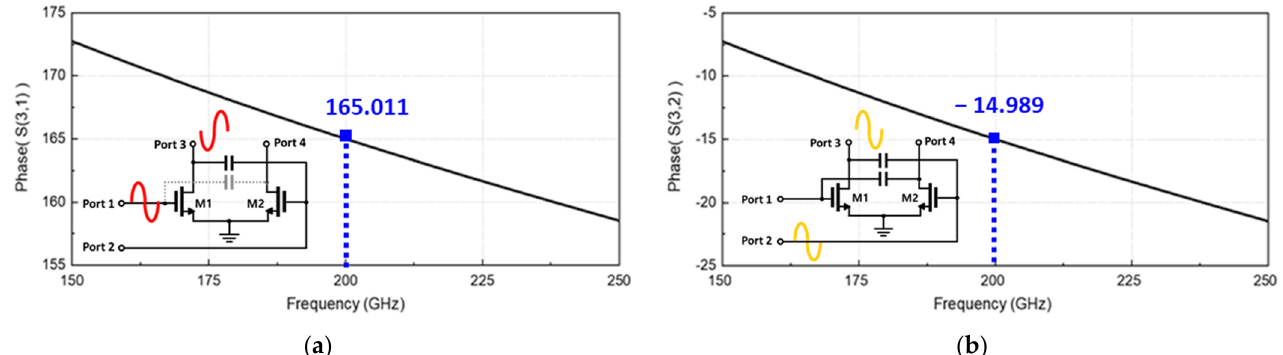
Figure 6. Simulated phase difference to the output node of the detector core transistor from: ( a ) a positive input port and ( b ) negative input port.